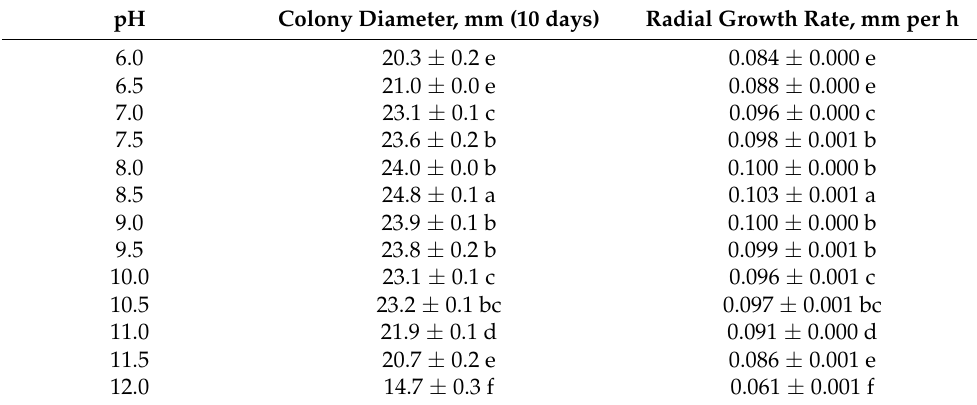
Table 1. Growth rate of P. melonis 502 colonies at different pH values.